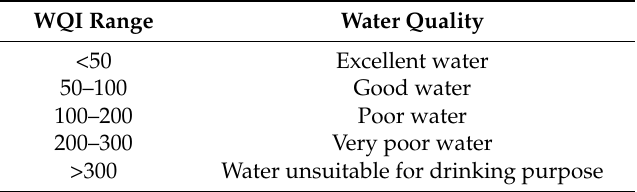
Table 3. The water quality classification based on the water quality index (WQI) value Singh and Hussian